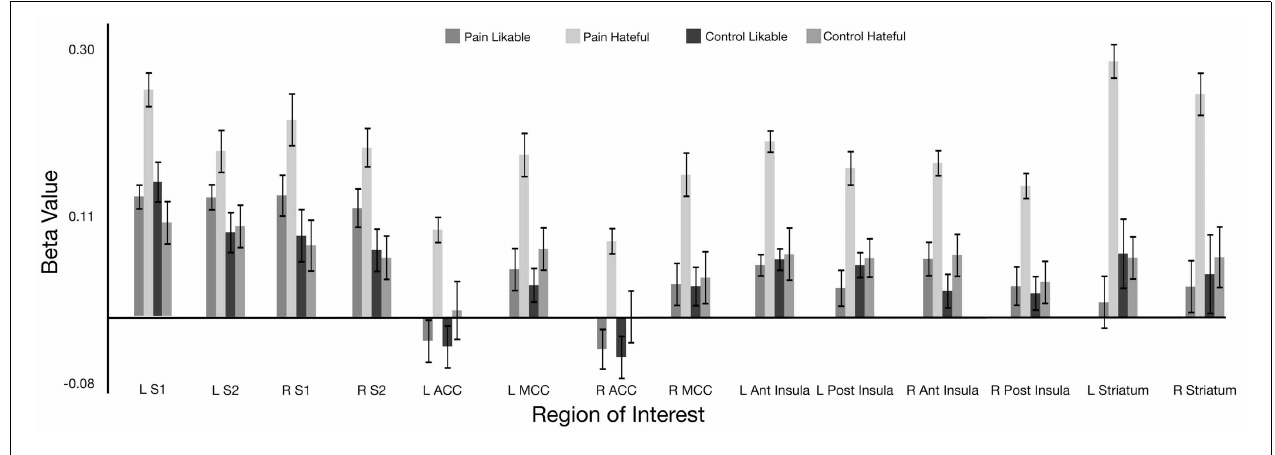
FIGURE 2 | Beta value for each condition within hand-drawn ROIs in the pain matrix regions. All ROIs show a significant difference between viewing likable and hateful people in pain at p < 0 .